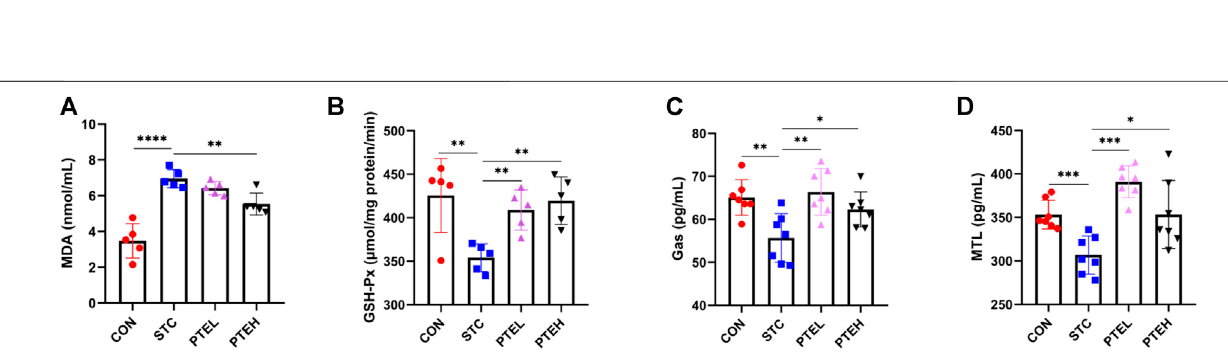
FIGURE 6 | GO functional enrichment analysis (A) and KEGG enrichment analysis of the PTE-STC intersection target gene (B) .